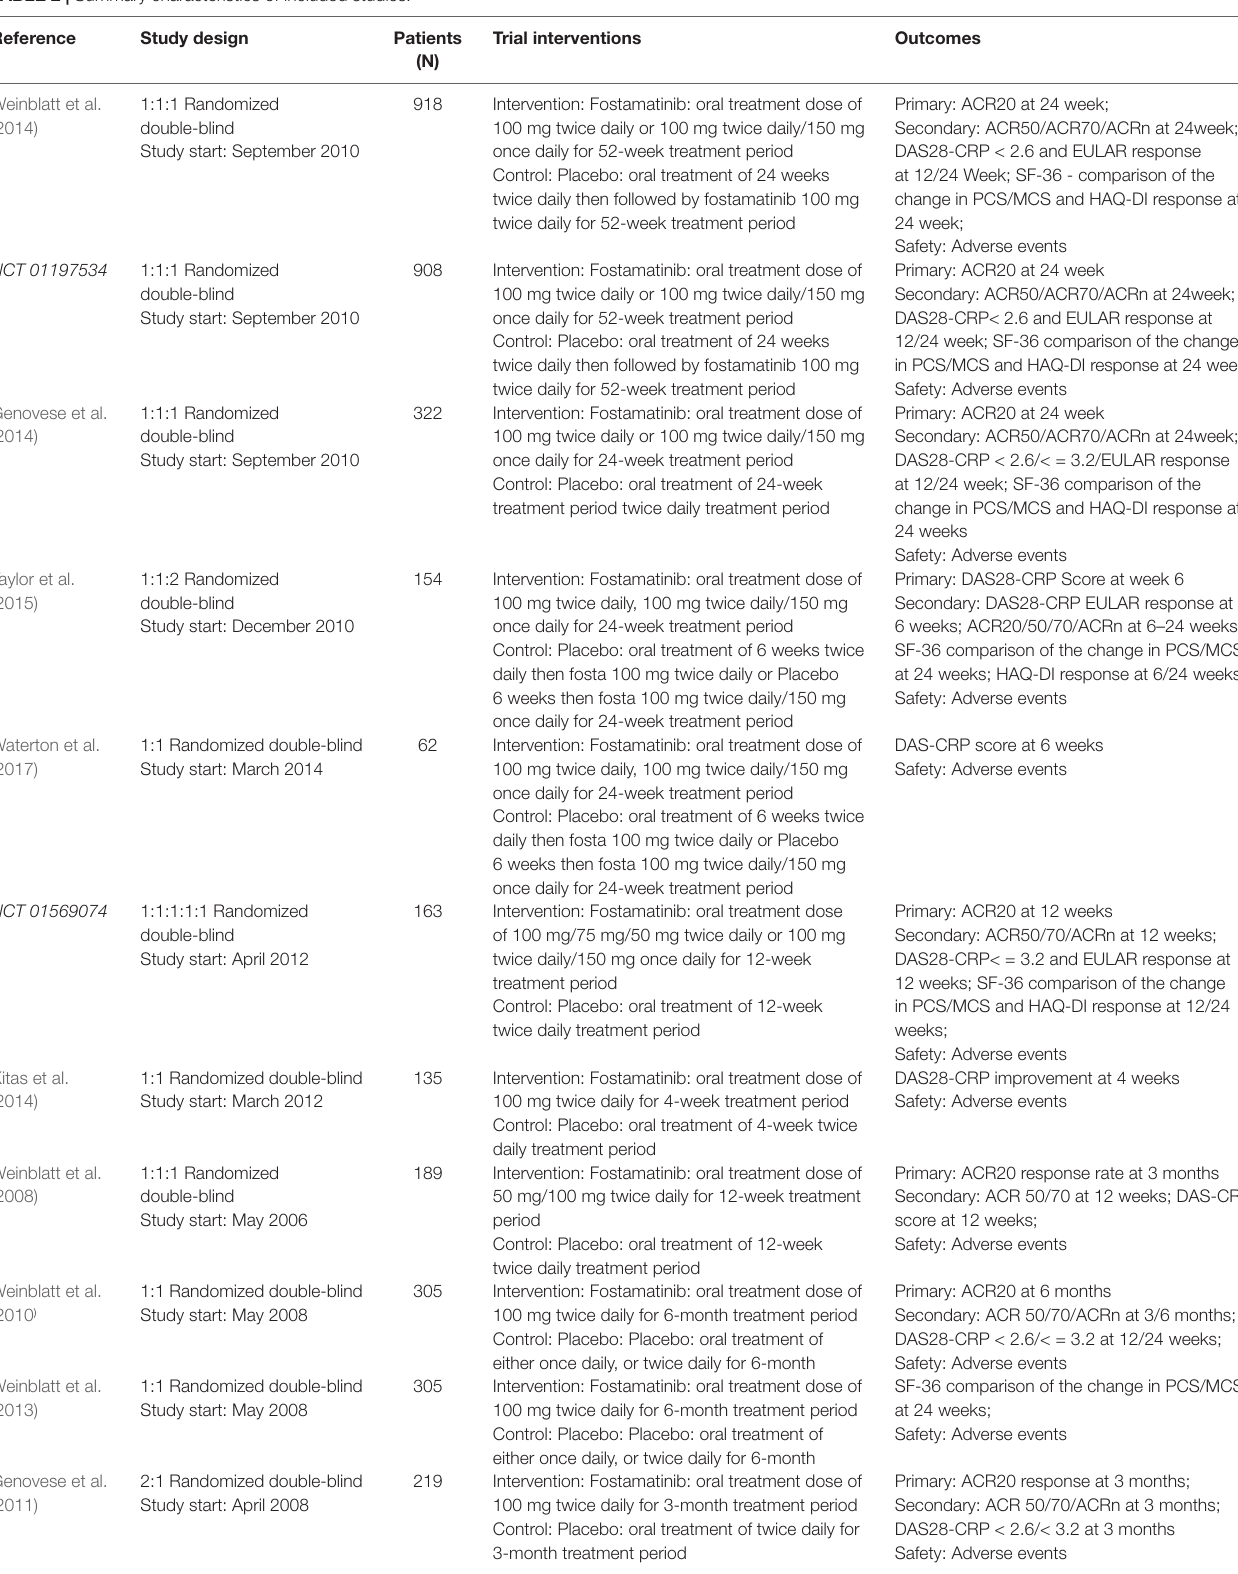
TABLE 2 | Summary characteristics of included